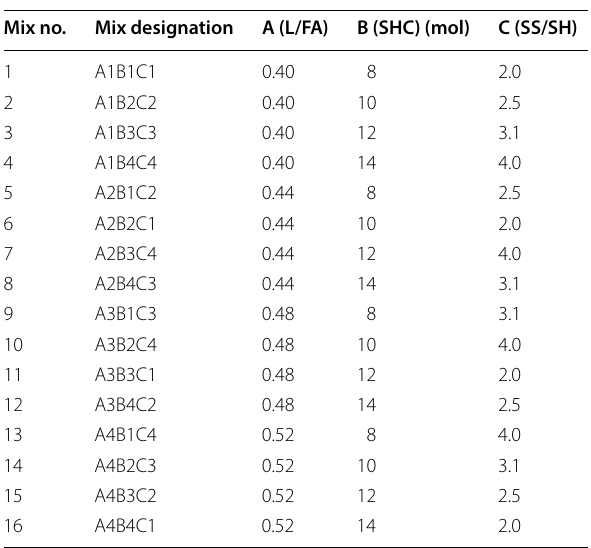
Table 4 The orthogonal experimental design